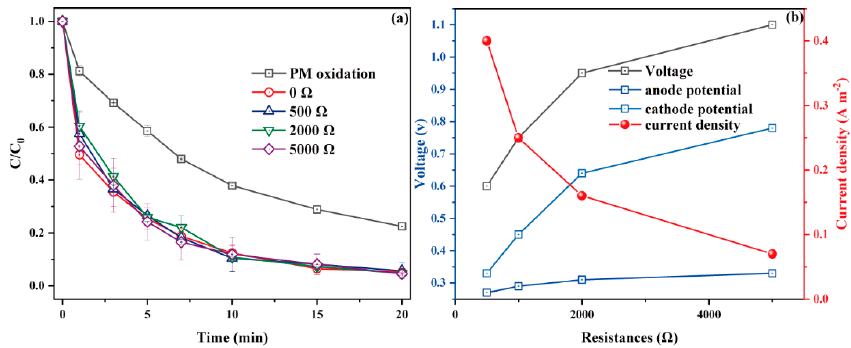
Figure 4. DCF removal ( a ), and voltage, cathode/anode potential and current density ( b ) at different values of external resistance ([PM] 0 = 30 µM; [DCF] 0 = 60 µM; pH = 3.0).